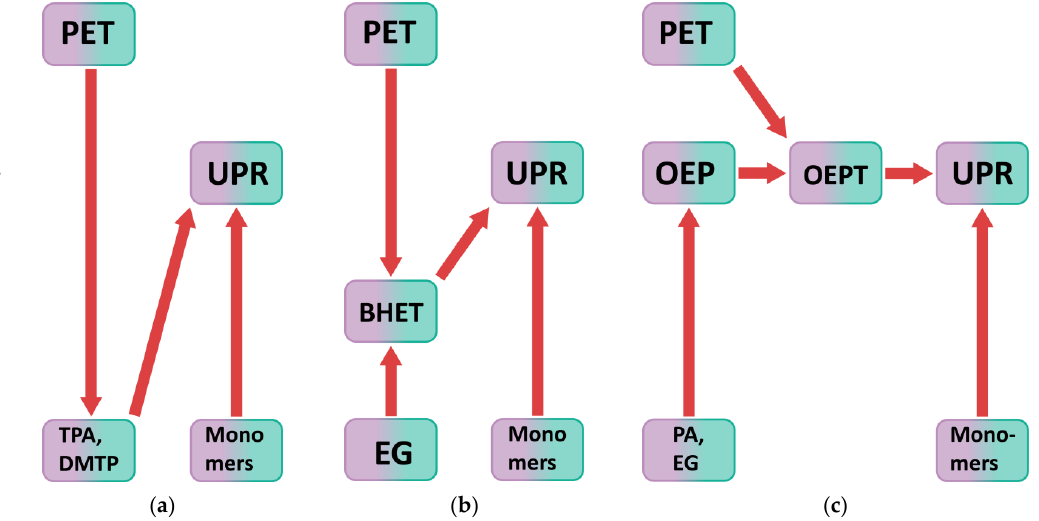
Figure 1. Different paths for the unsaturated polyester resins synthesis based on the products of post-consumer poly(ethylene terephthalate) chemical recycling: ( a ) PET hydrolysis or alcoholysis, where TPA—terephthalic acid, DMTP—dimethyl terephthalate; ( b ) PET heterogeneous glycolysis; ( c ) PET homogeneous glycolysis and interchain